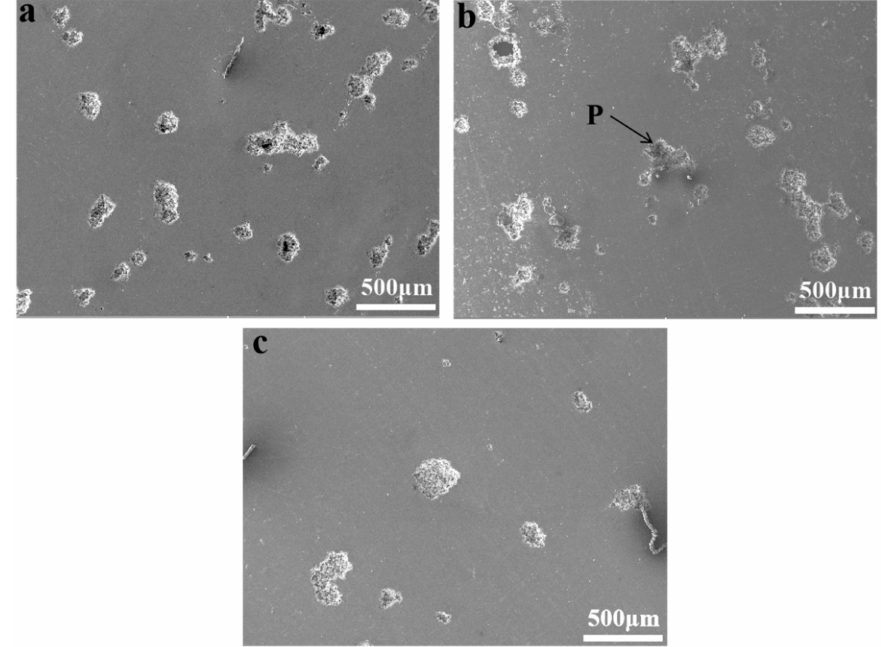
Figure 5. Corrosion surfaces of the Al–xFe–0.1Si–0.07La alloy foils tested in a 3.5% NaCl solution: ( a )